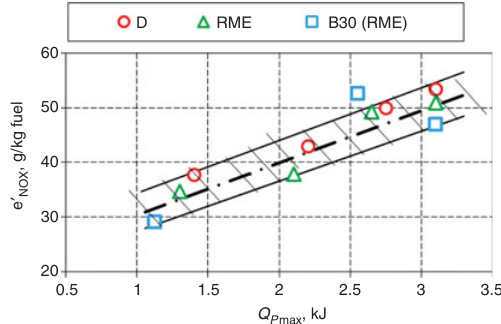
Fig. 6. Relationship of and Q P max when a diesel engine is running on D and